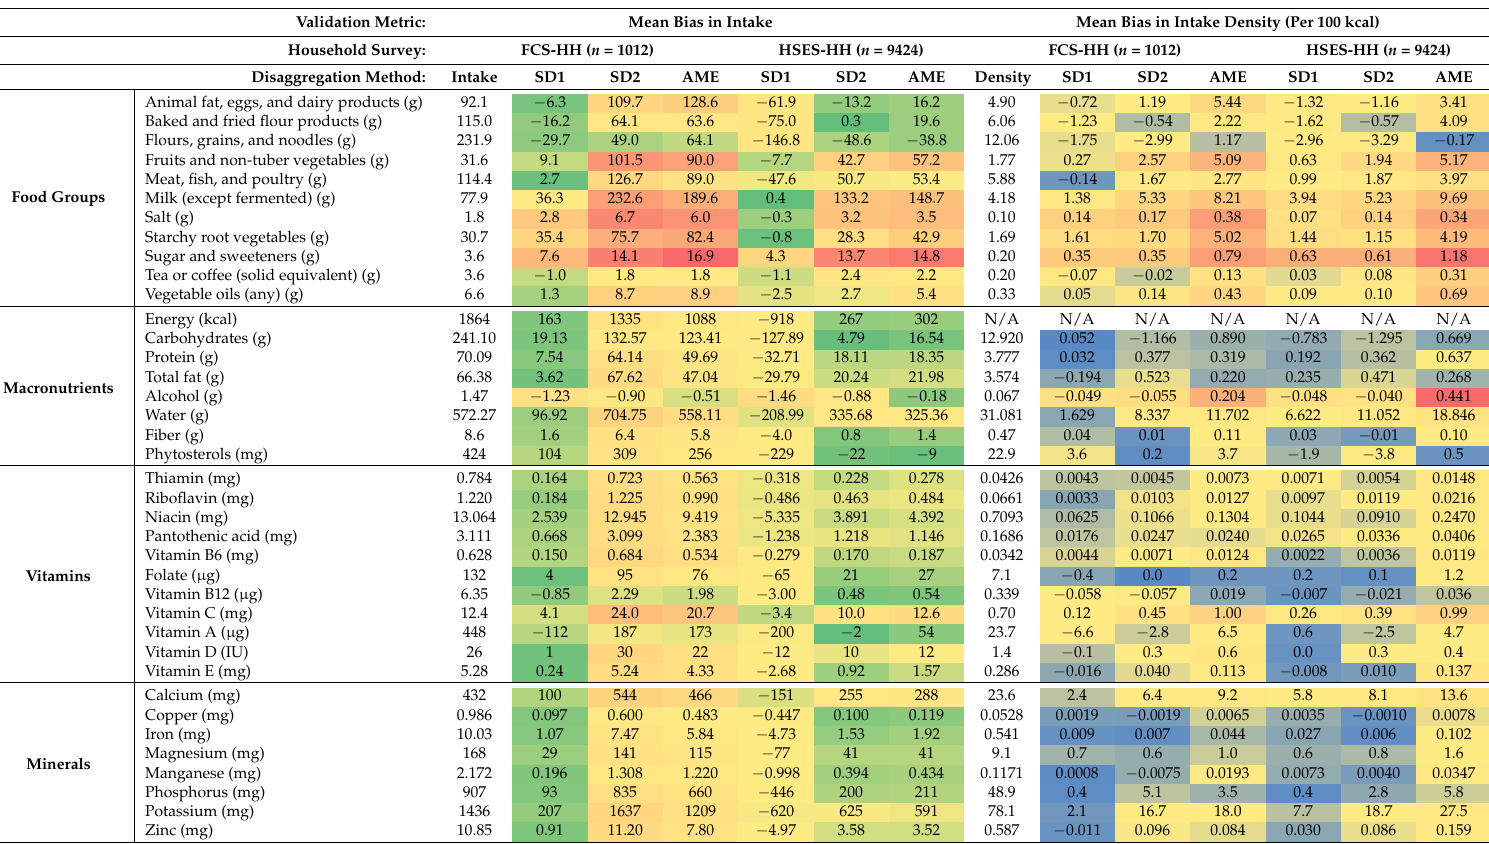
Table 2. Mean bias of disaggregated household consumption estimates of individuals’ food group and nutrient intake and intake density (per 100 kcal) across 14 age-sex groups (Aims 2 and